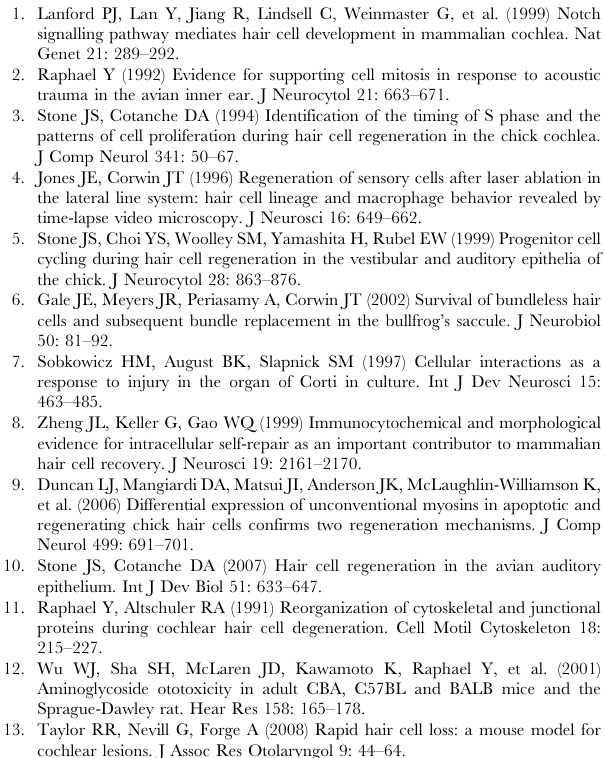
Table S1 Tests of between-subjects effects on inducing